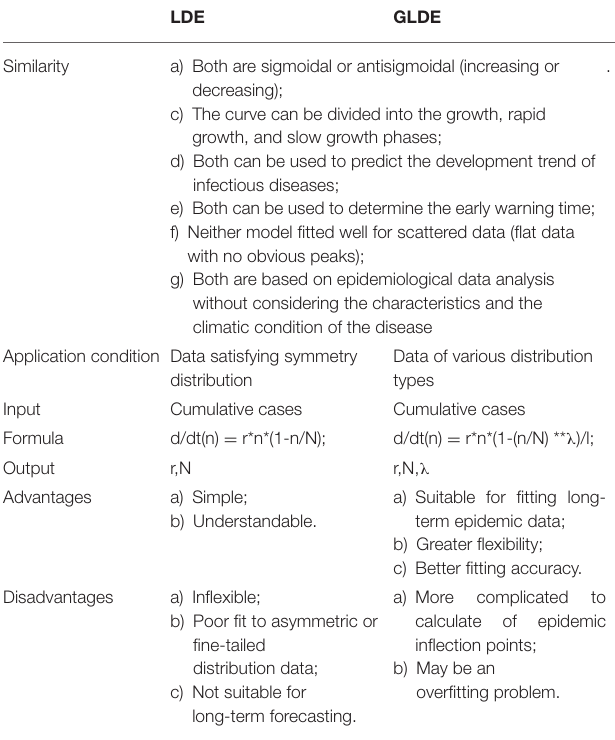
TABLE 4 | Comparison of logistic differential equation (LDE) and generalized logistic differential equation (GLDE). LDE